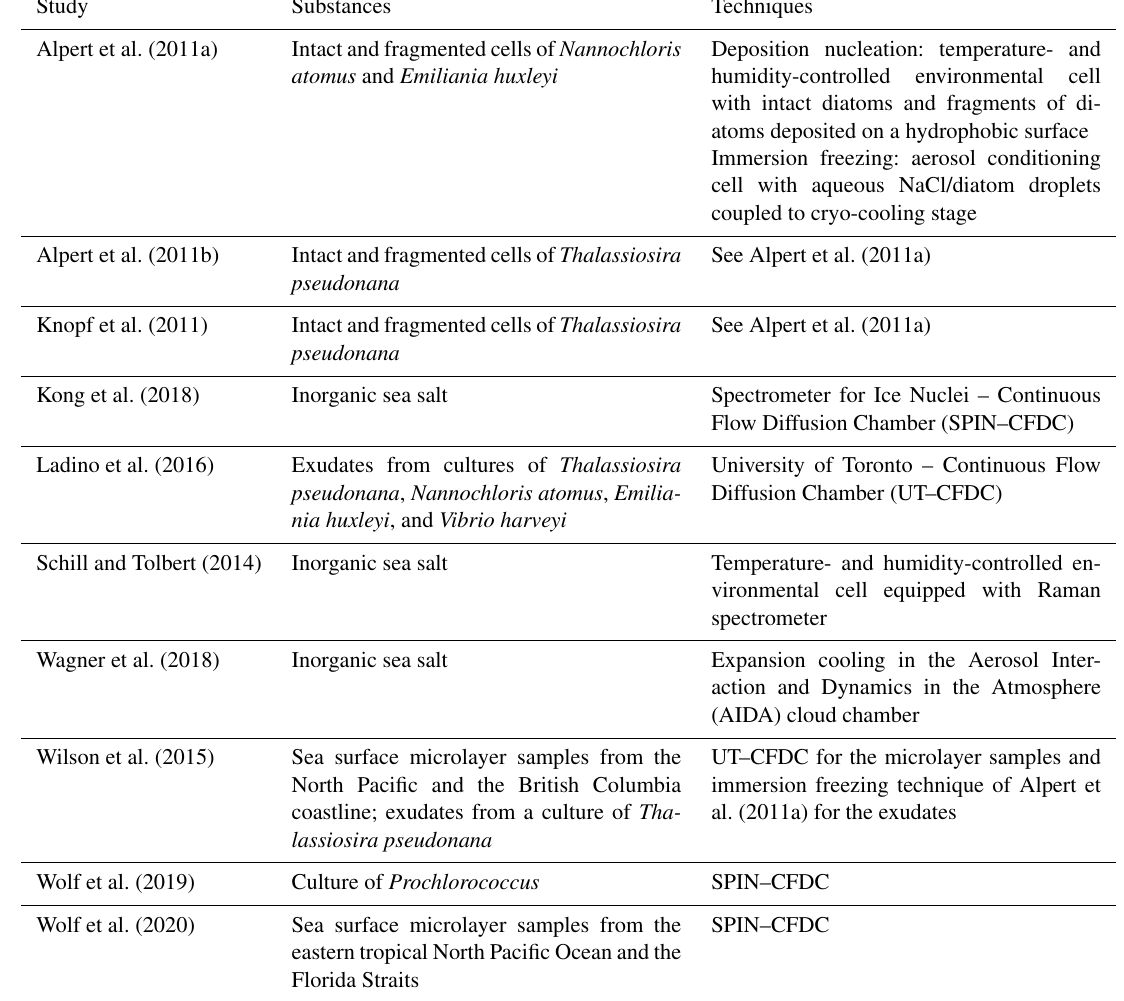
Table 1. Alphabetical list of previous ice nucleation measurements with SSA particles and their proxies at cirrus conditions, specifying the investigated substances and the employed ice nucleation measurement